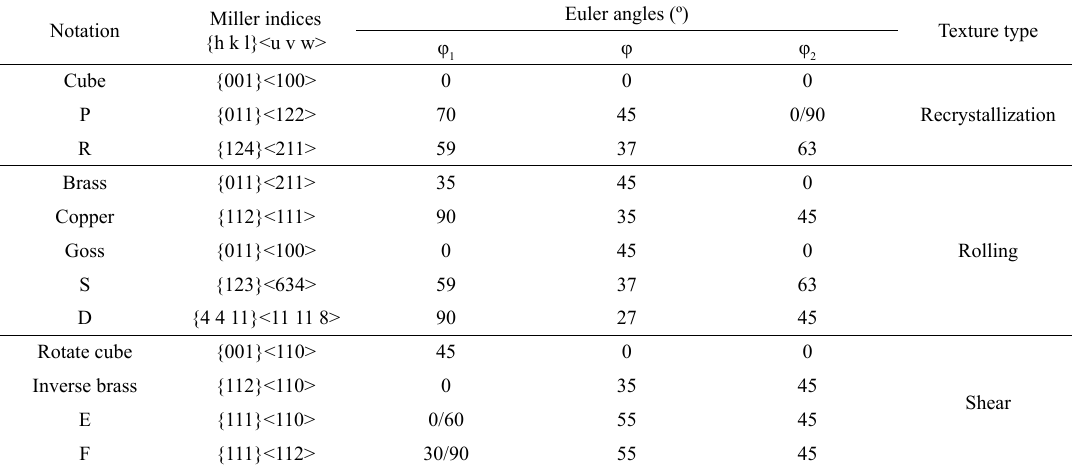
Table 1. Miller indices and Euler angles of f.c.c. rolling and shear orientations. Notation